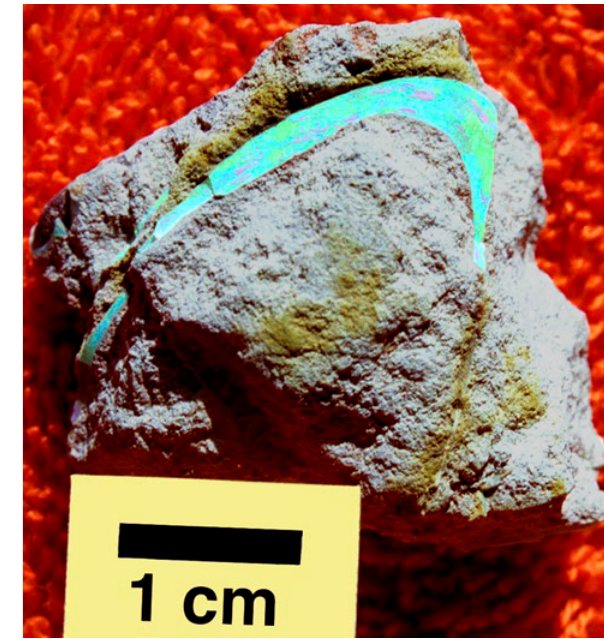
Figure 87. A calcareous fossil shell (brachiopod) has been com- pletely hydrolysed to a gelatinous hydroxy carbonate into which silicic acid [probably Si(OH) 4 ] has been able to diffuse to entirely replace the original shell with opal. This specimen is from Coober Pedy in South